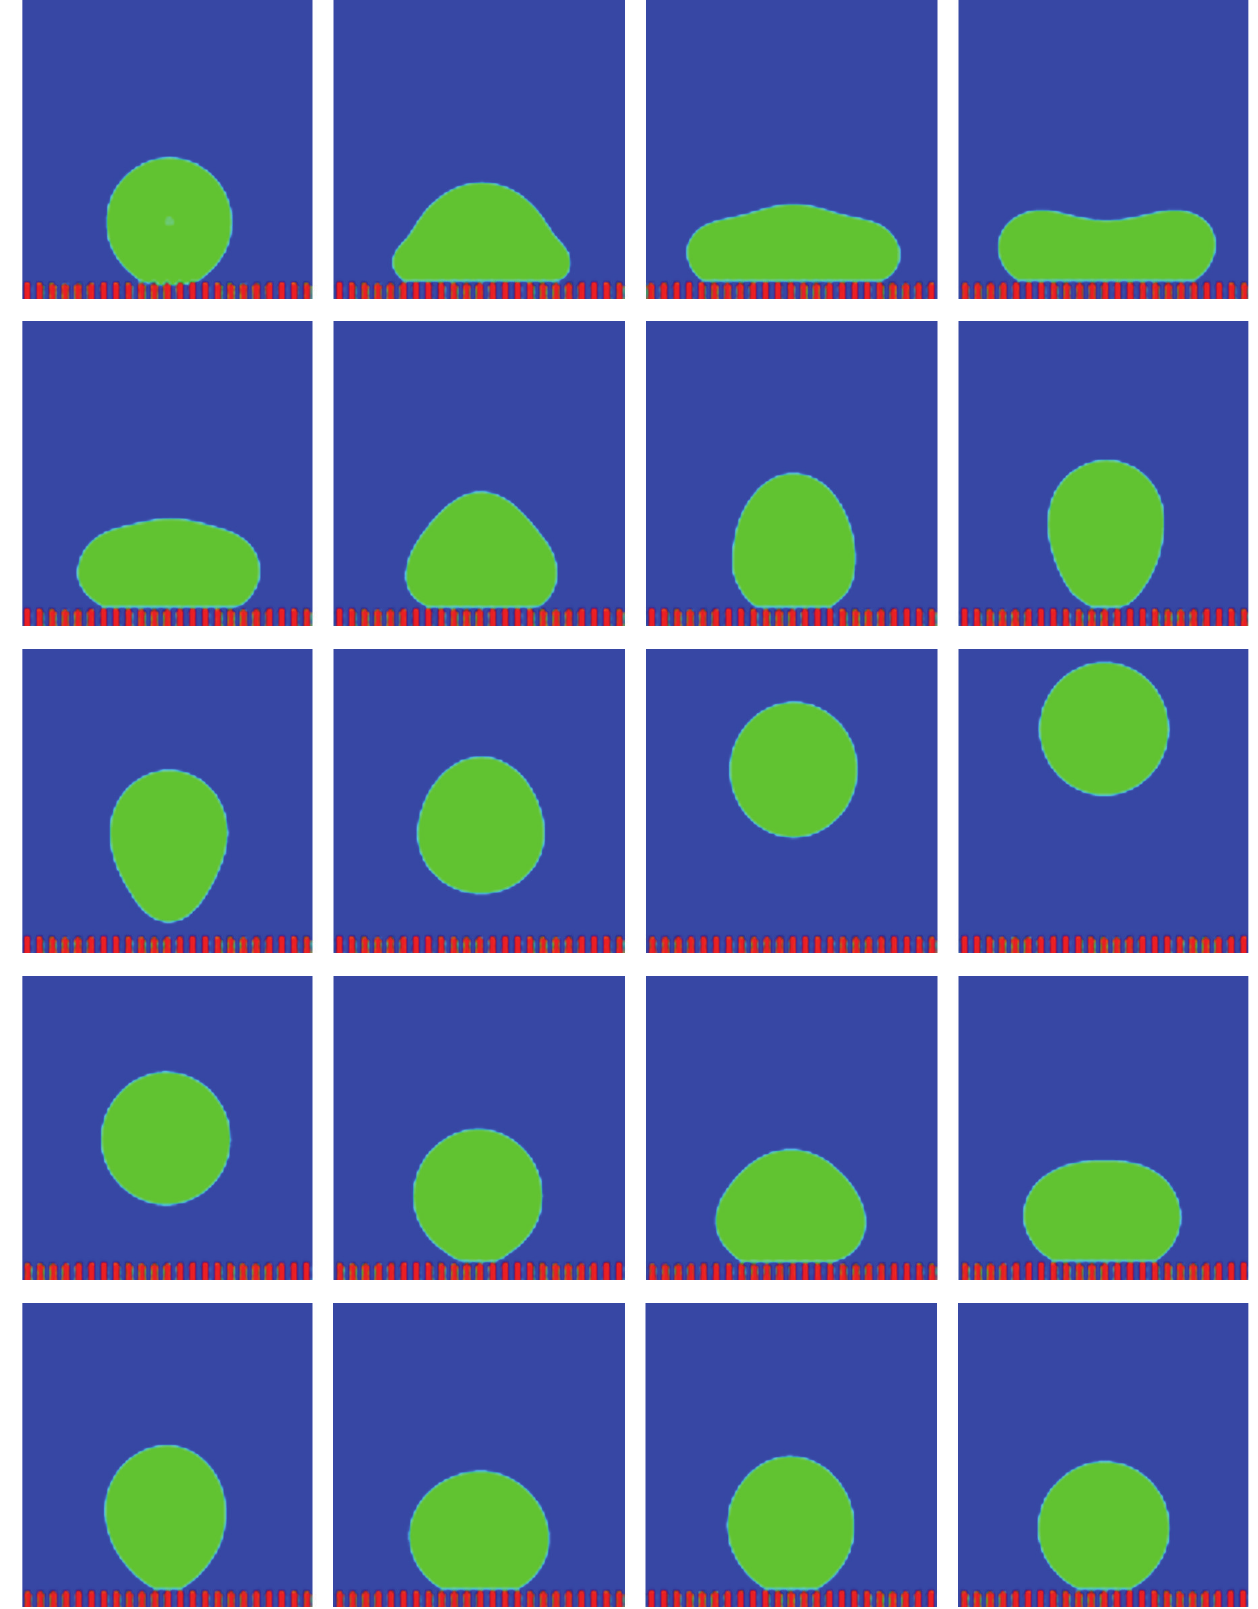
Figure 7: The dynamic behaviors of droplet impacting on hydrophobic surface (CA = 151.8 ∘